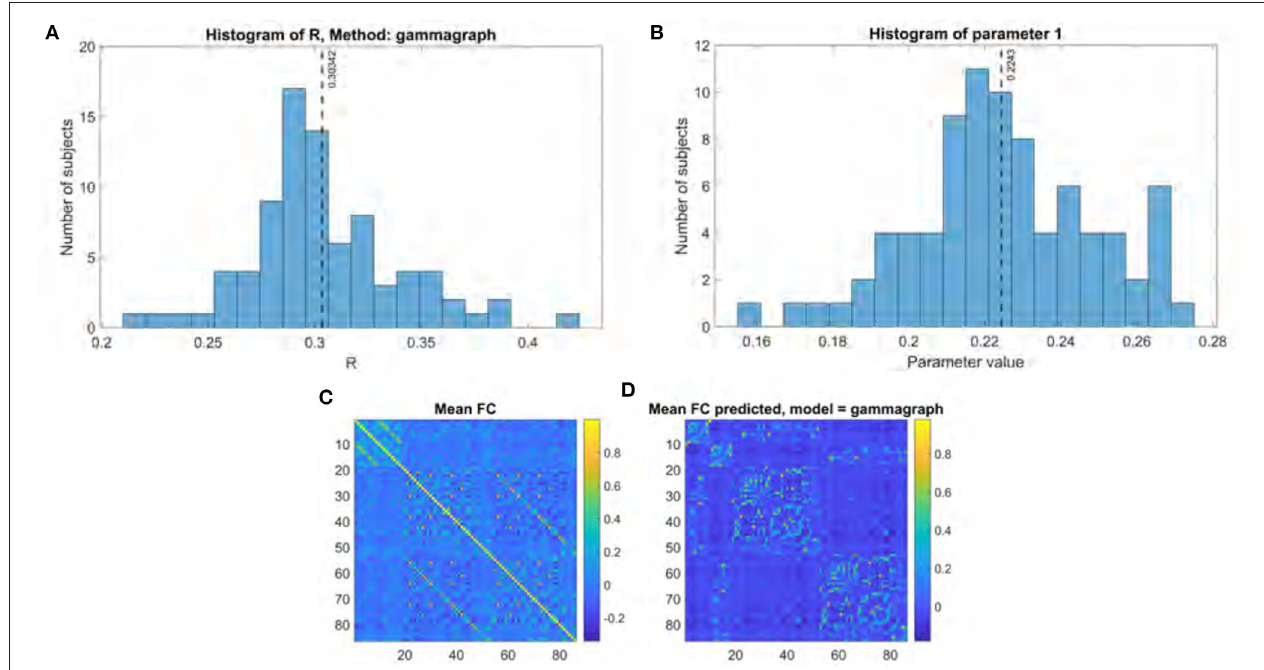
FIGURE 2 | Gamma model performance. (A) Histogram of R score. (B) Histogram of fitted parameter. (C) Mean functional connectome over all subjects. (D) Mean functional connectome predicted by model.